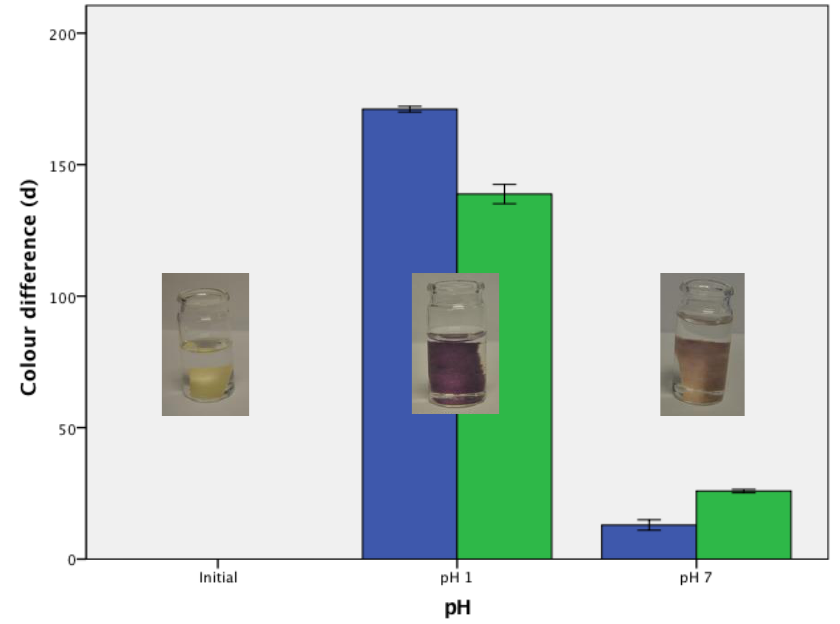
Figure 3. Colour differences observed during the reversibility studies in solution for UVM7-dye ( blue ) and UVM7-cotton ( green ). Inset: photographs of UVM7-cotton at the diverse pH.